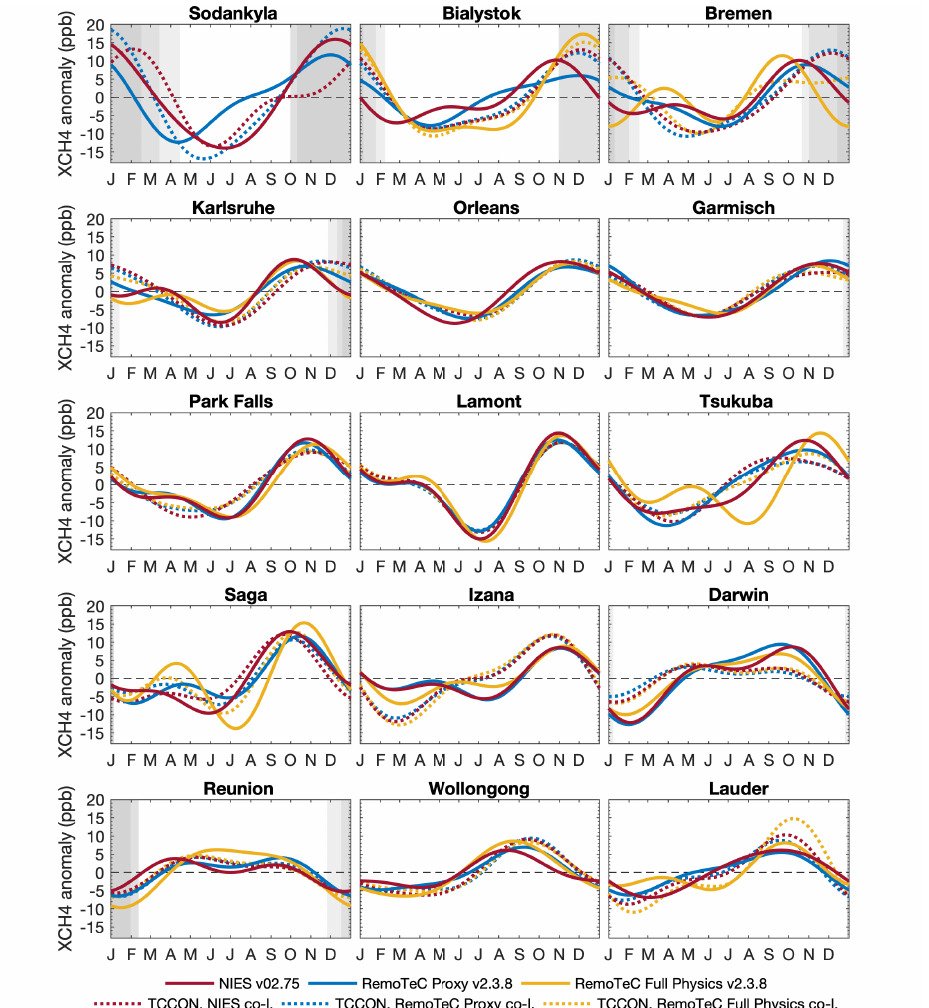
Figure 7. Detrended seasonal cycle fits for three GOSAT XCH 4 retrievals (solid lines) and for co-located TCCON retrievals (dashed lines) evaluated at 11 sites in the Northern Hemisphere and four sites in the Southern Hemisphere. The sites are arranged by their latitude from the northernmost (Sodankylä) to the southernmost (Lauder). Shaded areas refer to the periods with no co-located